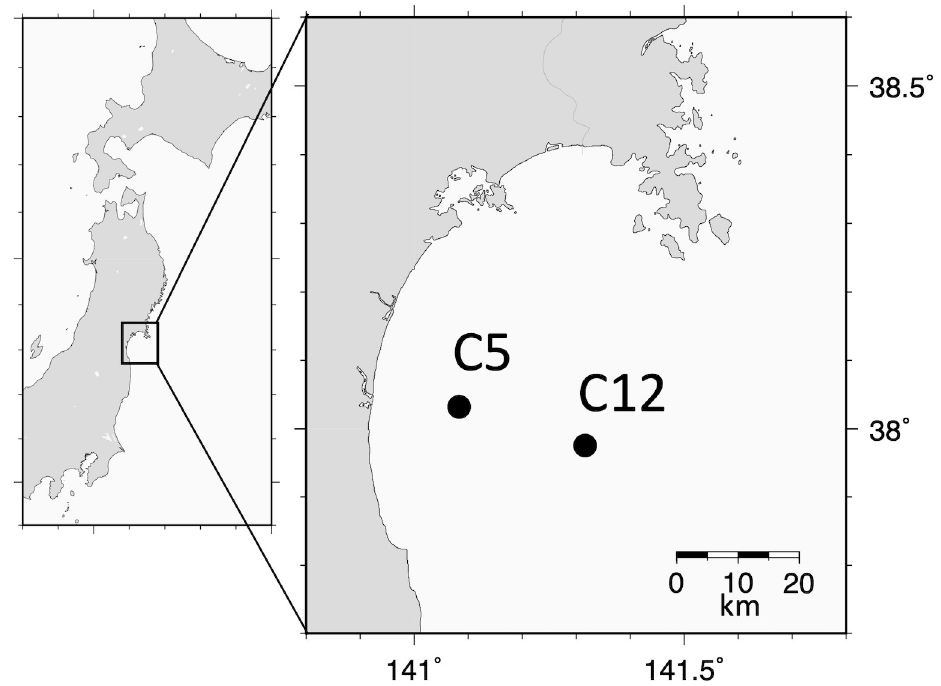
Fig 1. Map of Sendai Bay showing the sampling sites. These maps were prepared using the Generic Mapping Tools (https://www.generic-mapping-tools.org/).